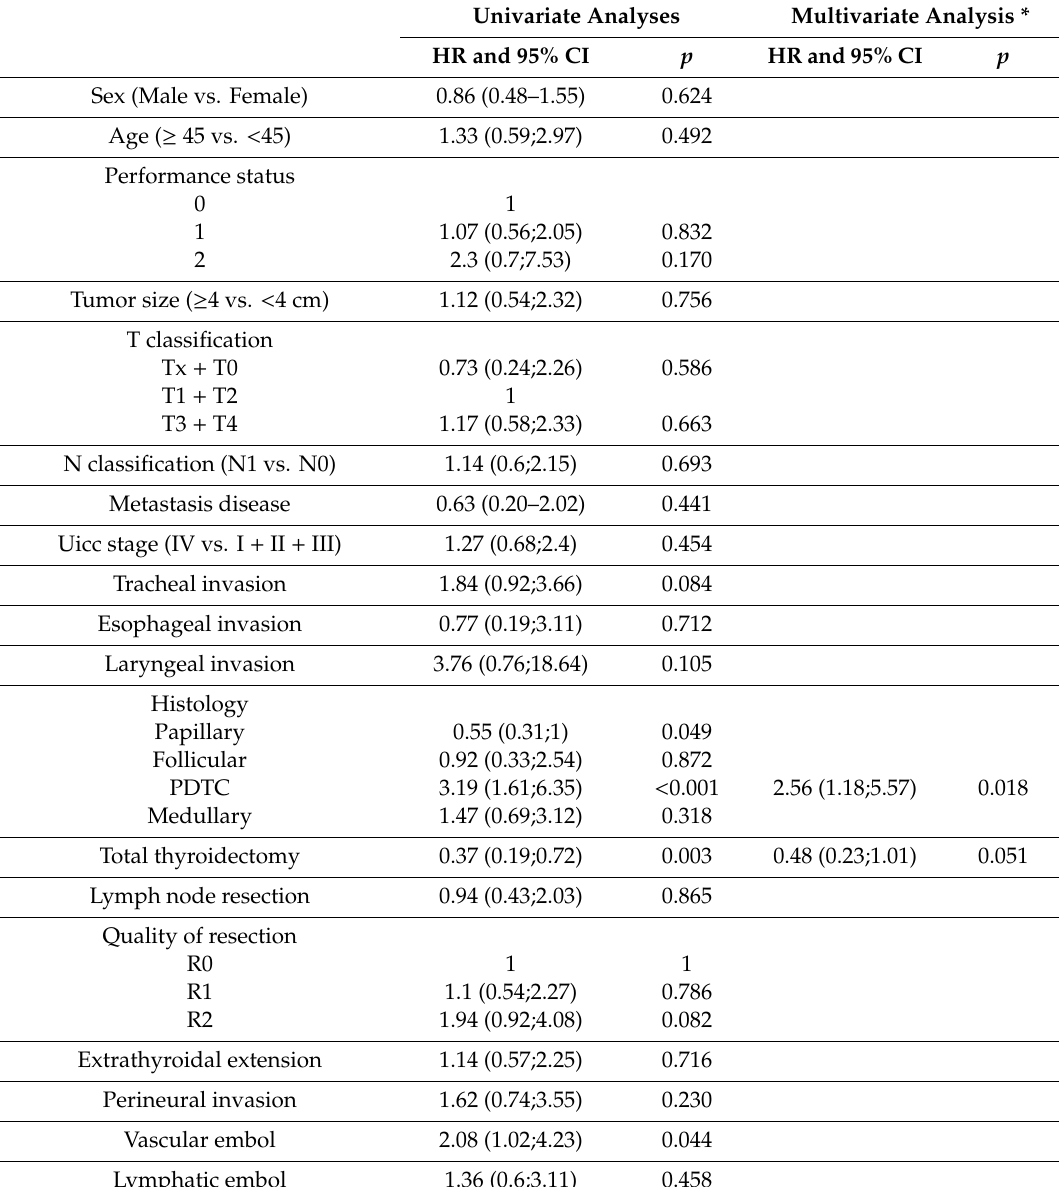
Table 2. Prognostic factors of locoregional recurrence after multiple imputations in univariate and multivariate analyses in the external beam radiotherapy (EBRT)